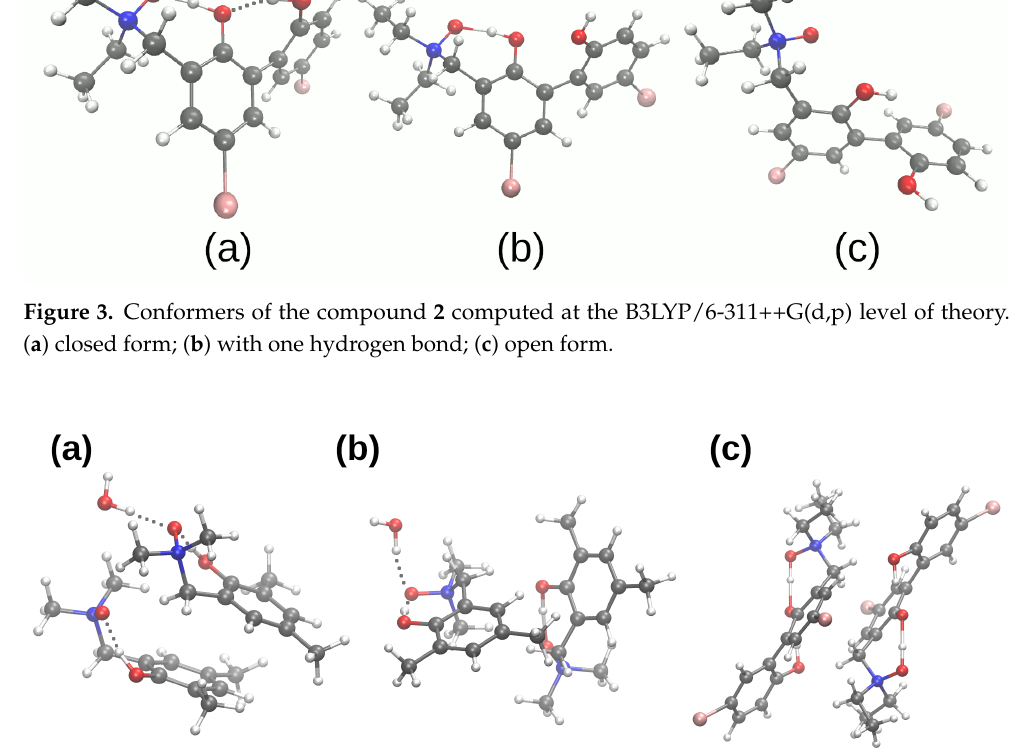
Figure 4. Dimers investigated in the SAPT study. ( a ) dimer 1 of the compound 1 with water molecule; ( b ) dimer 2 of the compound 1 with water molecule; ( c ) dimer 1 of the compound 2 .